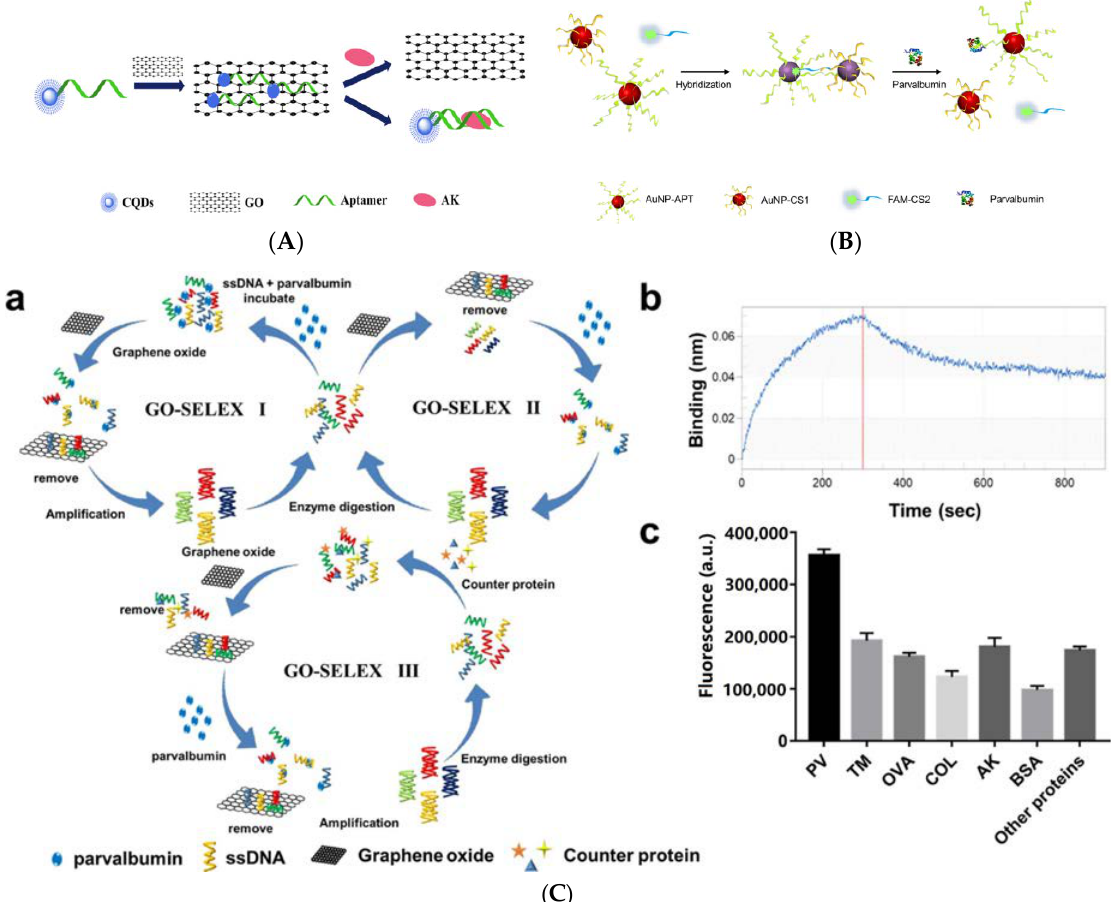
Figure 3. ( A ) Schematic of a “on-off-on” fluorescence aptasensor for AK detection. Reproduced with permission from [158]. Copyright Microchemical Journal, 2020. ( B ) Schematic of a dual-mode fluorescence sensor for PV detection based on AuNP color changes and FAM-CS2 fluorescence changes. ( C ) a: Schematic of the aptamer selection procedure by capturing GO-SELEX; b: Affinity of Apt5 towards PV; c: Specificity of Apt5 towards PV. Reproduced with permission from [159]. Copyright Microchemical Journal,